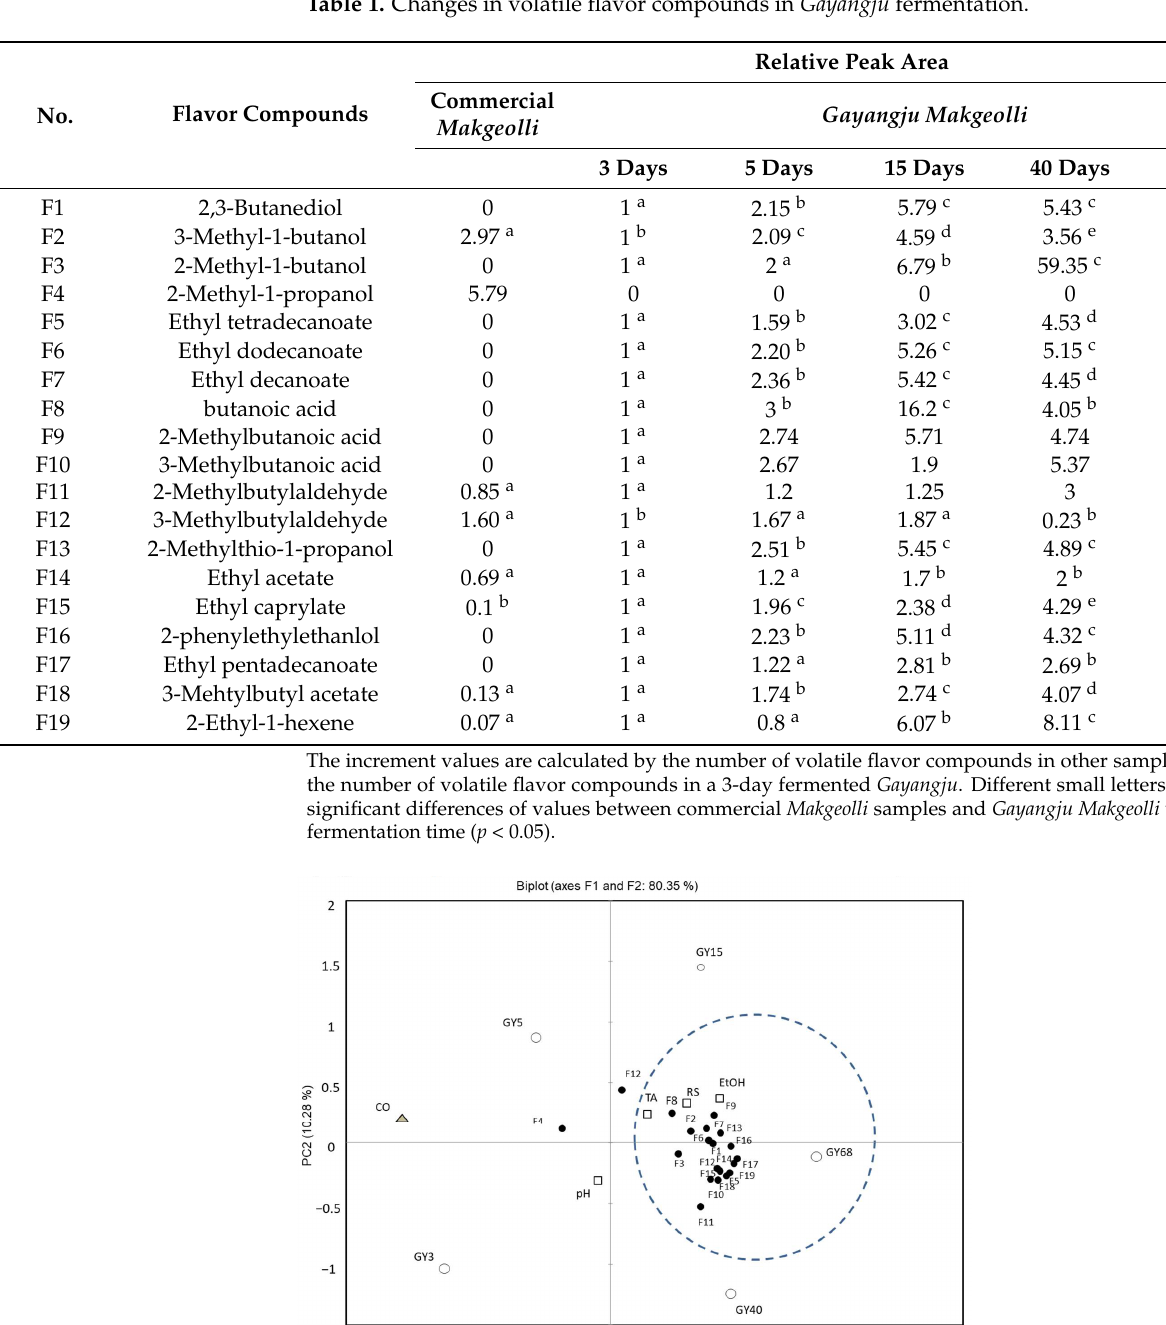
Table 1. Changes in volatile flavor compounds in Gayangju fermentation.